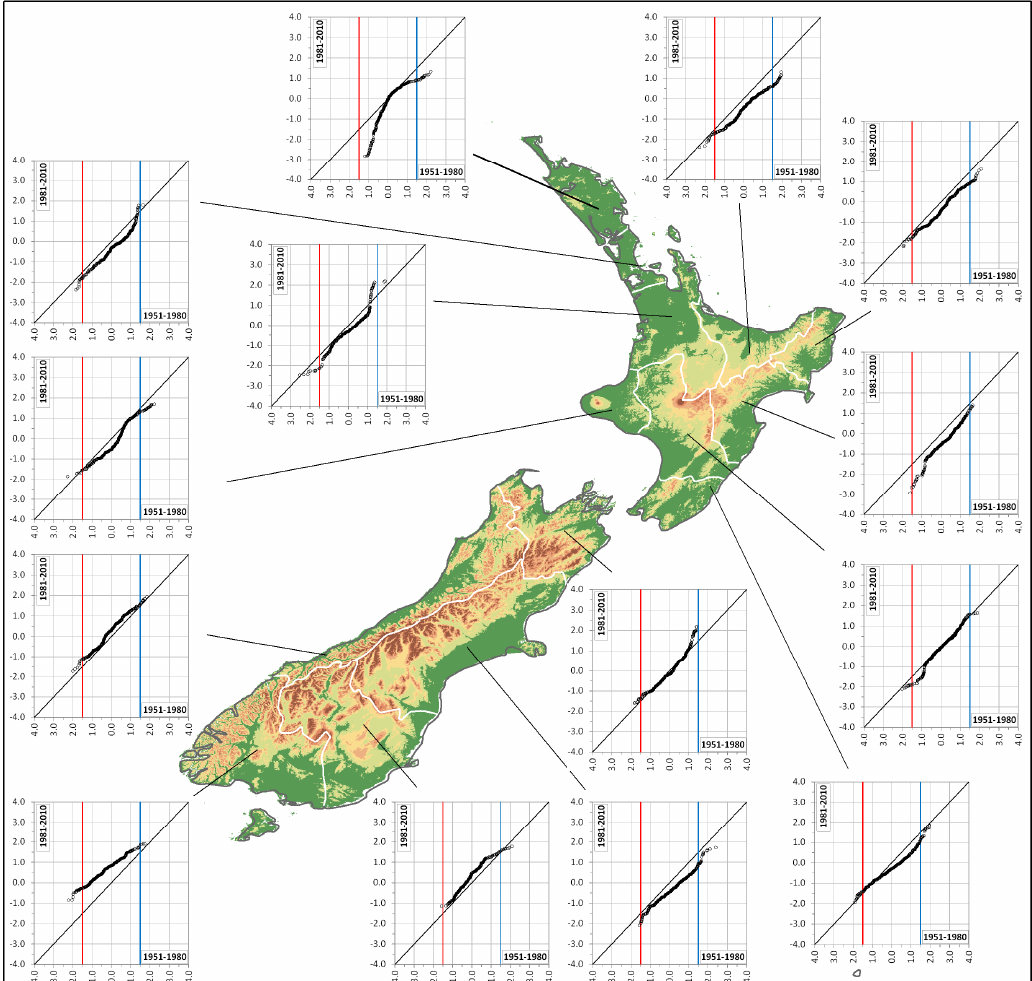
Figure 7. Regional results of the ITA method applied to the 24-month SPI.